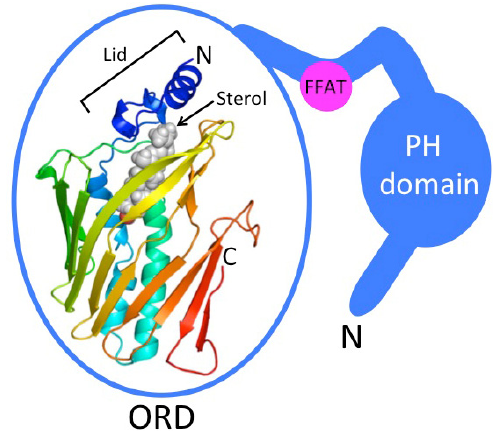
Figure 1. Schematic structure of ORP proteins. ORD, OSBP-related ligand binding domain, represents human ORP1 ORD modeled by using the yeast Osh4p structure [33] as a template. Bound sterol, which stabilizes a closed conformation of a flexible ‘Lid’ structure, is depicted as a gray ball-model. β -strands are displayed as flat arrows and α -helical secondary structures as helices. While “Short” subtype ORPs, such as yeast Osh4p-Osh7p, consist of a mere ORD, the “Long” subtype family members (most mammalian ORPs belong to this category) carry an N-terminal extension (blue) with a pleckstrin homology (PH) domain interacting with phosphoinositides and a short peptide motif (two phenylalanines in an acidic tract, FFAT) that targets the